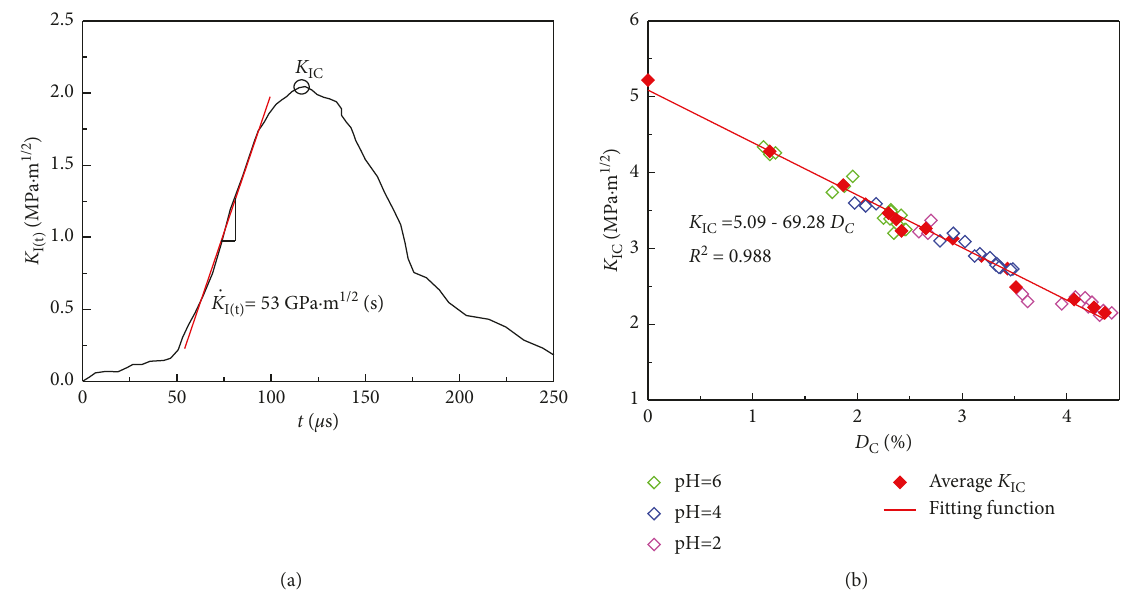
Figure 6: (a) Typical stress intensity factor-time curve in a dynamic NSCB test, (b) variation in dynamic fracture toughness versus damage